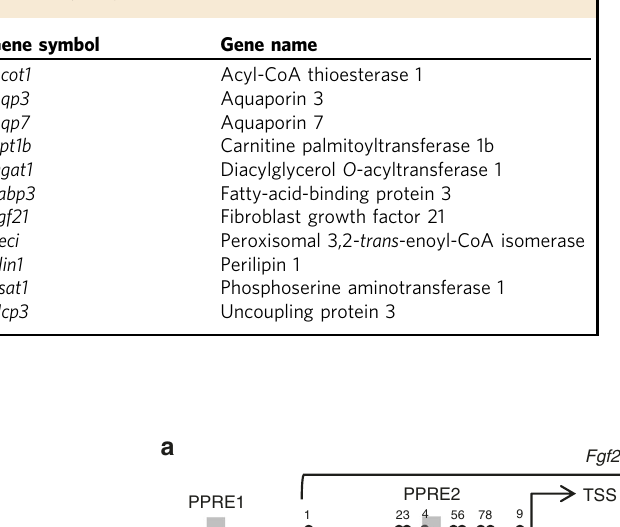
Table 1 PPAR α target genes which were DNA hypomethylated at both D16 and 14W (Wy-offspring vs.